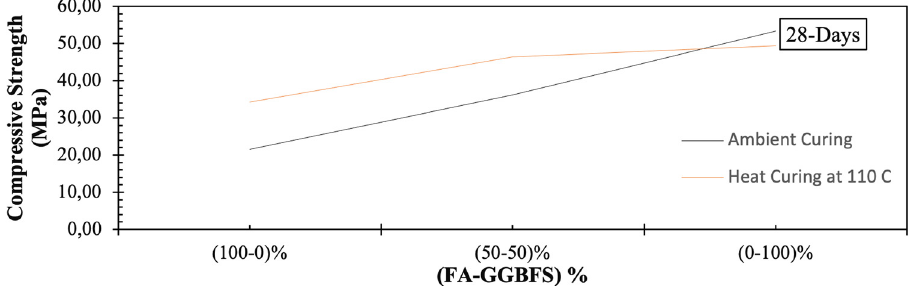
Figure 4: The e ff ect of binder ratio and curing condition on the compressive strength at 28